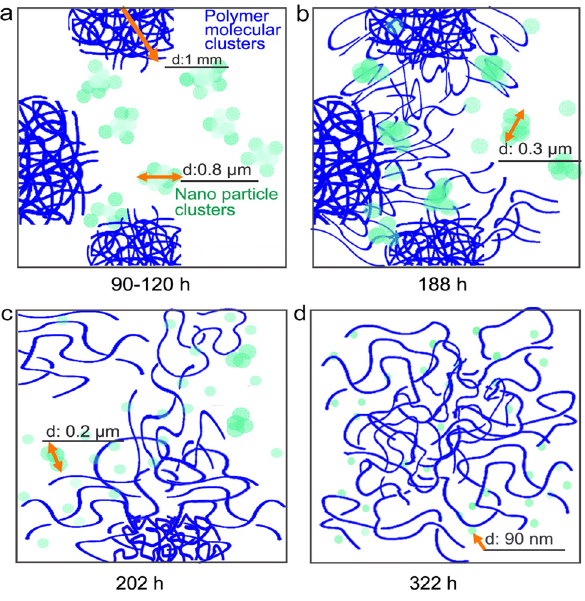
Figure 4: The mechanism of uniformly mixing LDPE and NPs gov - erned by time, temperature, and concentration of LDPE and